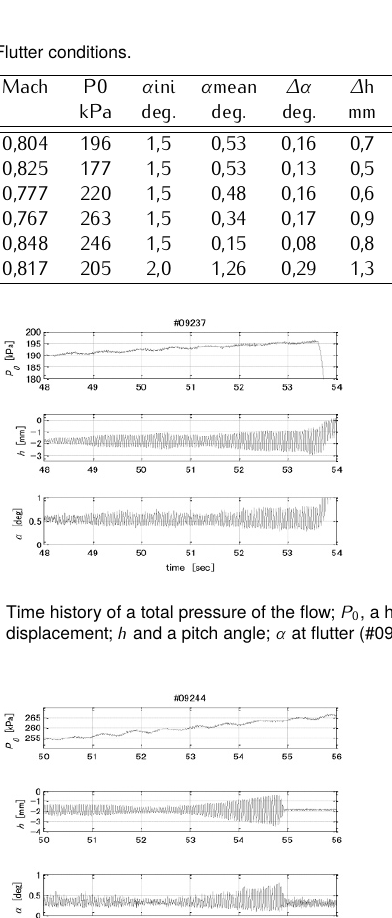
Figure 10. Time history of a total pressure of the flow; P displacement; h and a pitch angle; α at flutter (#09244).